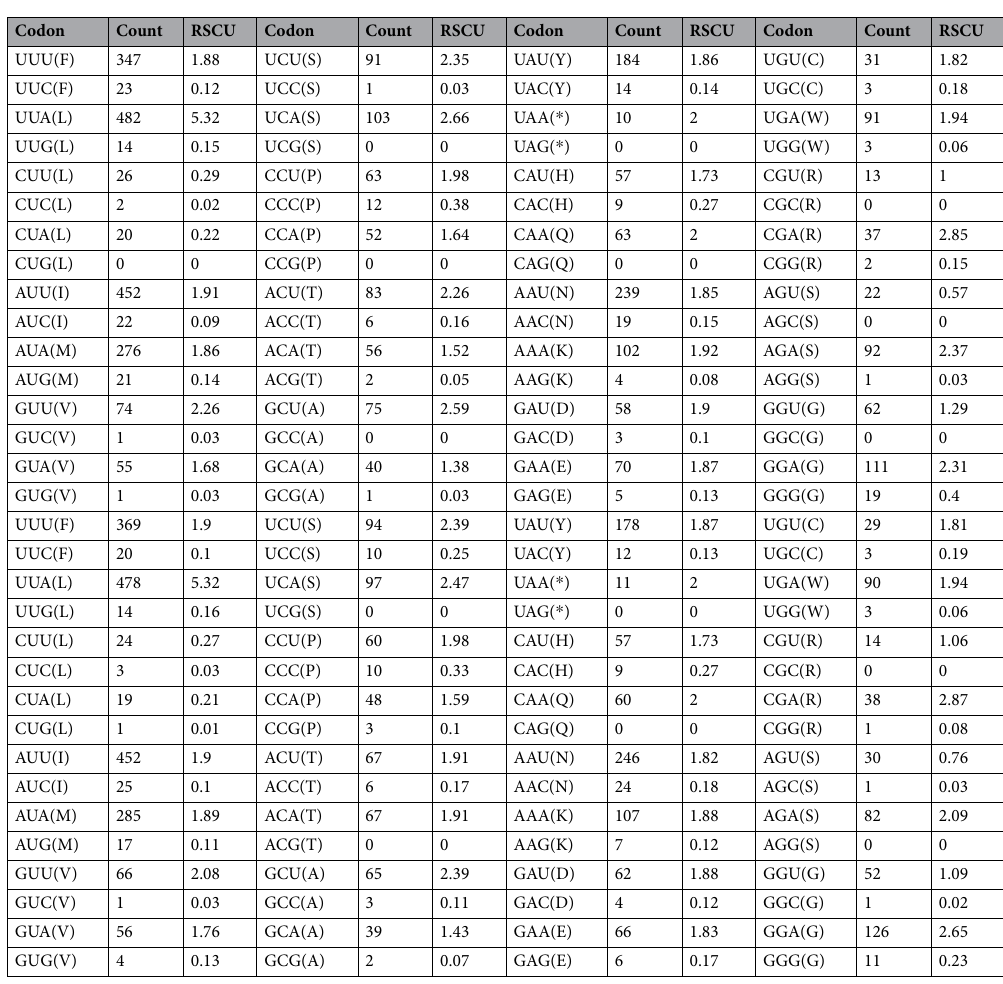
Table 5. Codon number and RSCU in the A . rubiginosa and R . menciana mitochondrial